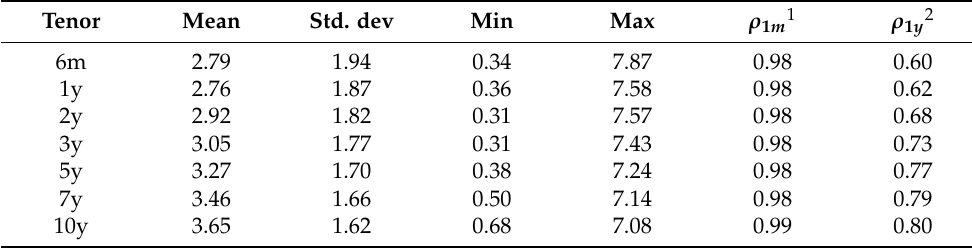
Table 1. Descriptive statistics of zero-coupon